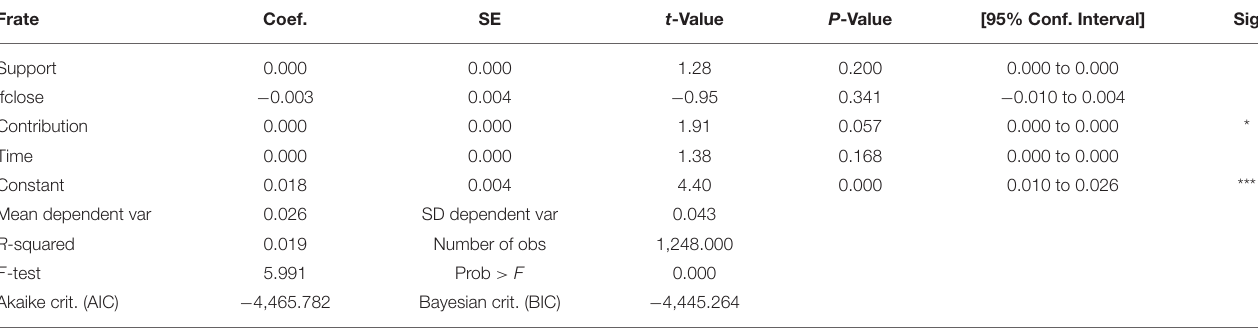
TABLE 8 | Regression results for the robustness test model of the influence of aid intensity on prevalence. Prevalence Coef. SE t -Value [95% Conf. Interval] Support 0.002 Ifclose